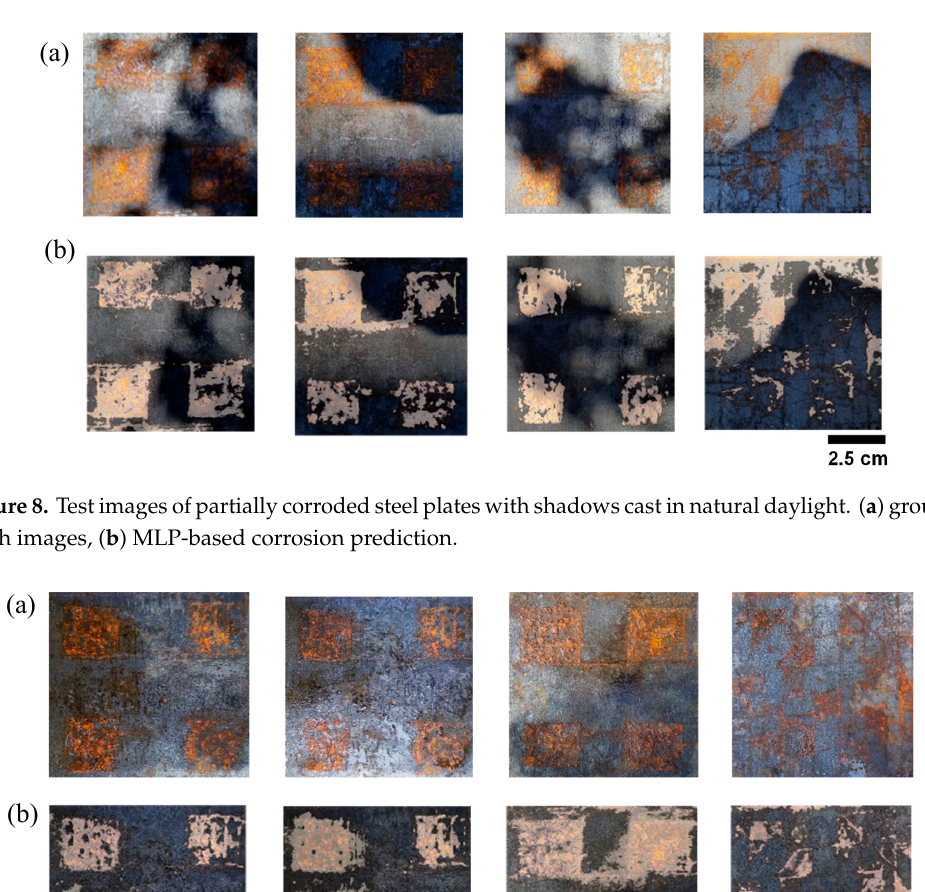
Figure 7. Test images of partially corroded steel plates acquired at different illuminations of natural daylight. ( a ) ground truth images, ( b ) MLP-based corrosion prediction.